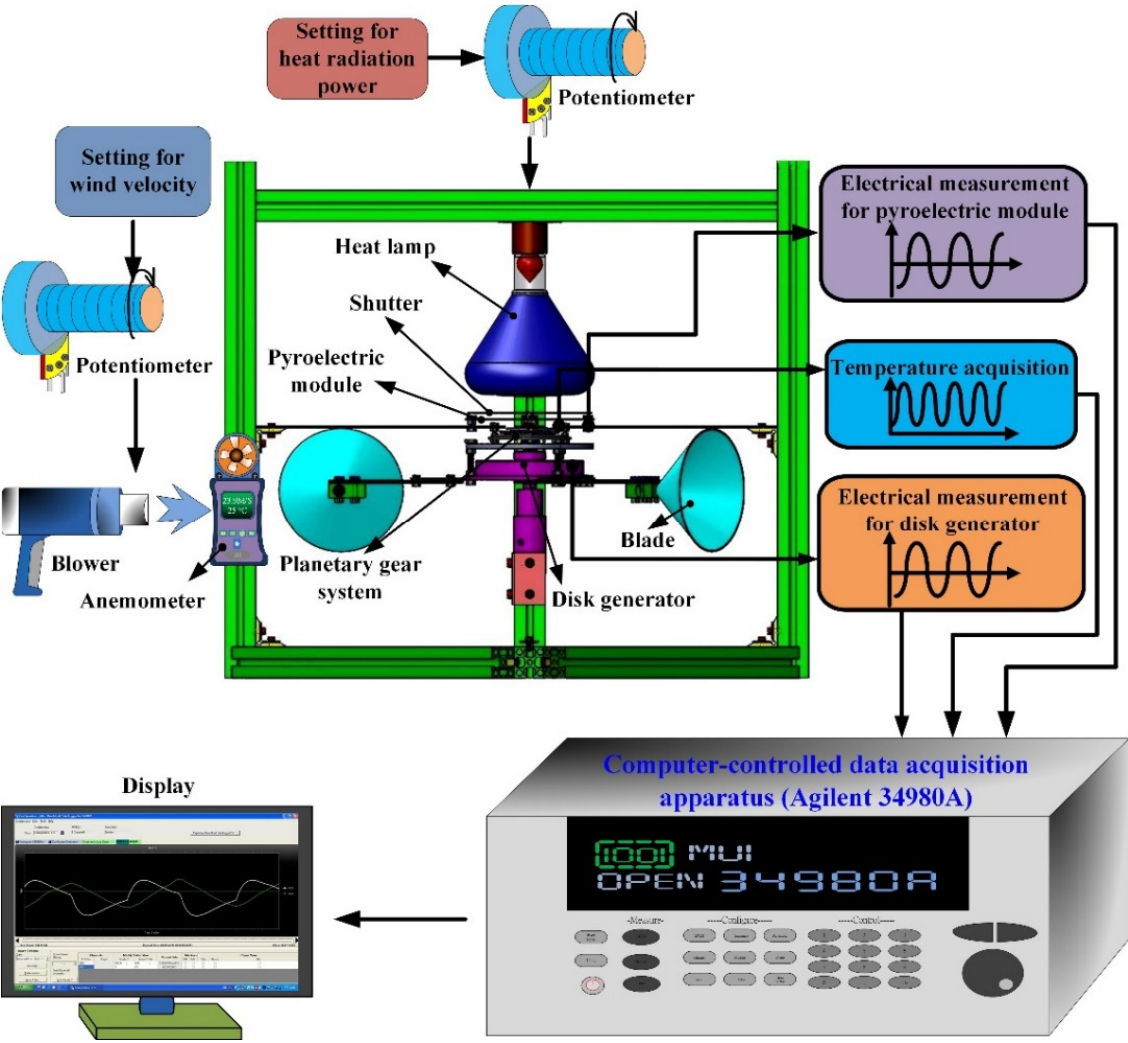
Figure 3. Measurement setup for the pyroelectric harvester integrating solar radiation with wind